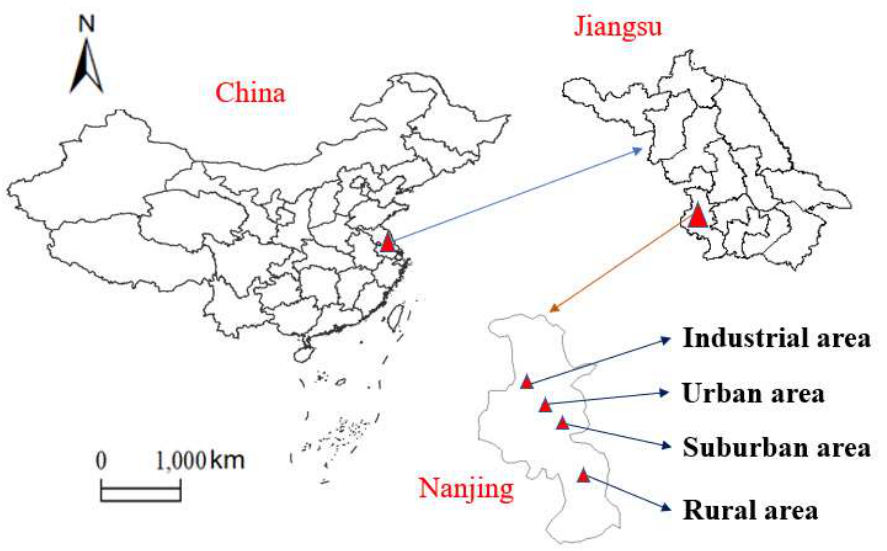
Figure 1. Locations of the four representative air sampling sites in Nanjing city, eastern China.